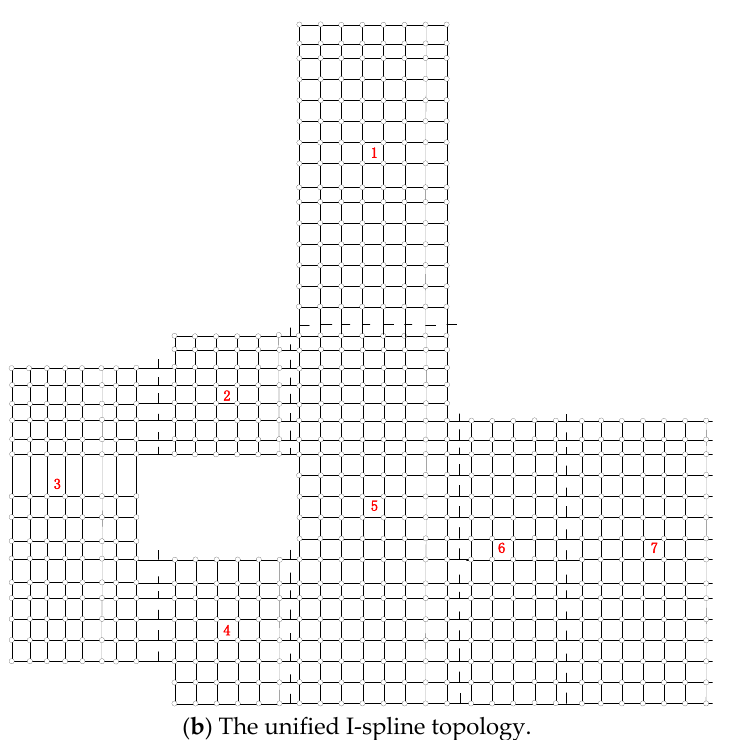
( b ) The unified I-spline topology. Figure 14. Unified representation of seven separate NURBS models. Figure 14. Unified representation of seven separate NURBS